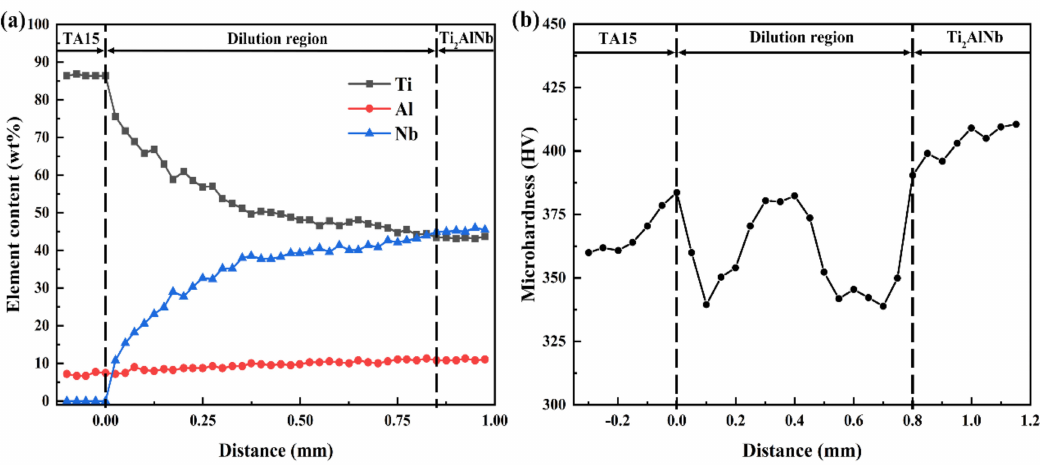
Figure 12. Composition and microhardness distribution at the dilute region of LSF TA15 / Ti 2 AlNb dual alloy: ( a ) composition; ( b )